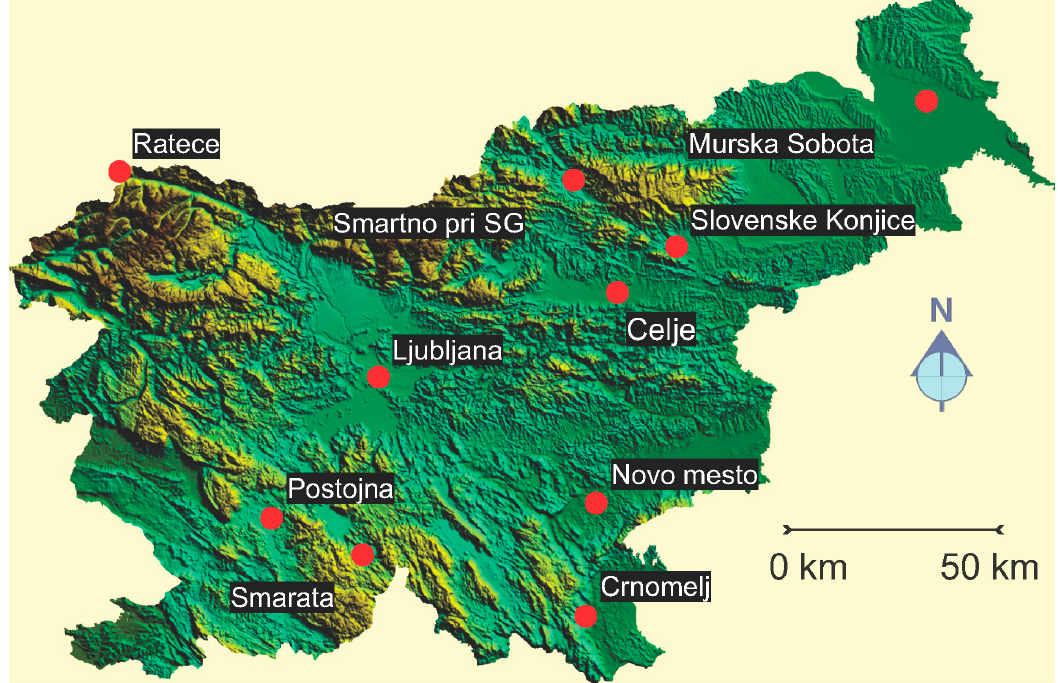
Figure 1. Locations of the rainfall stations used in this study, shown on the topography map of